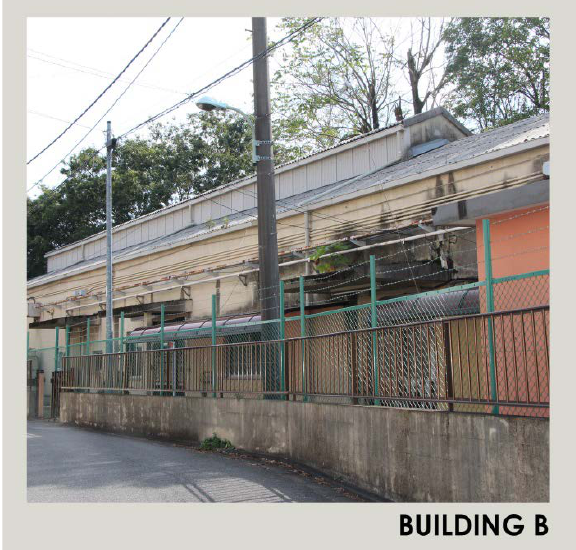
Figure 4: Building case of study